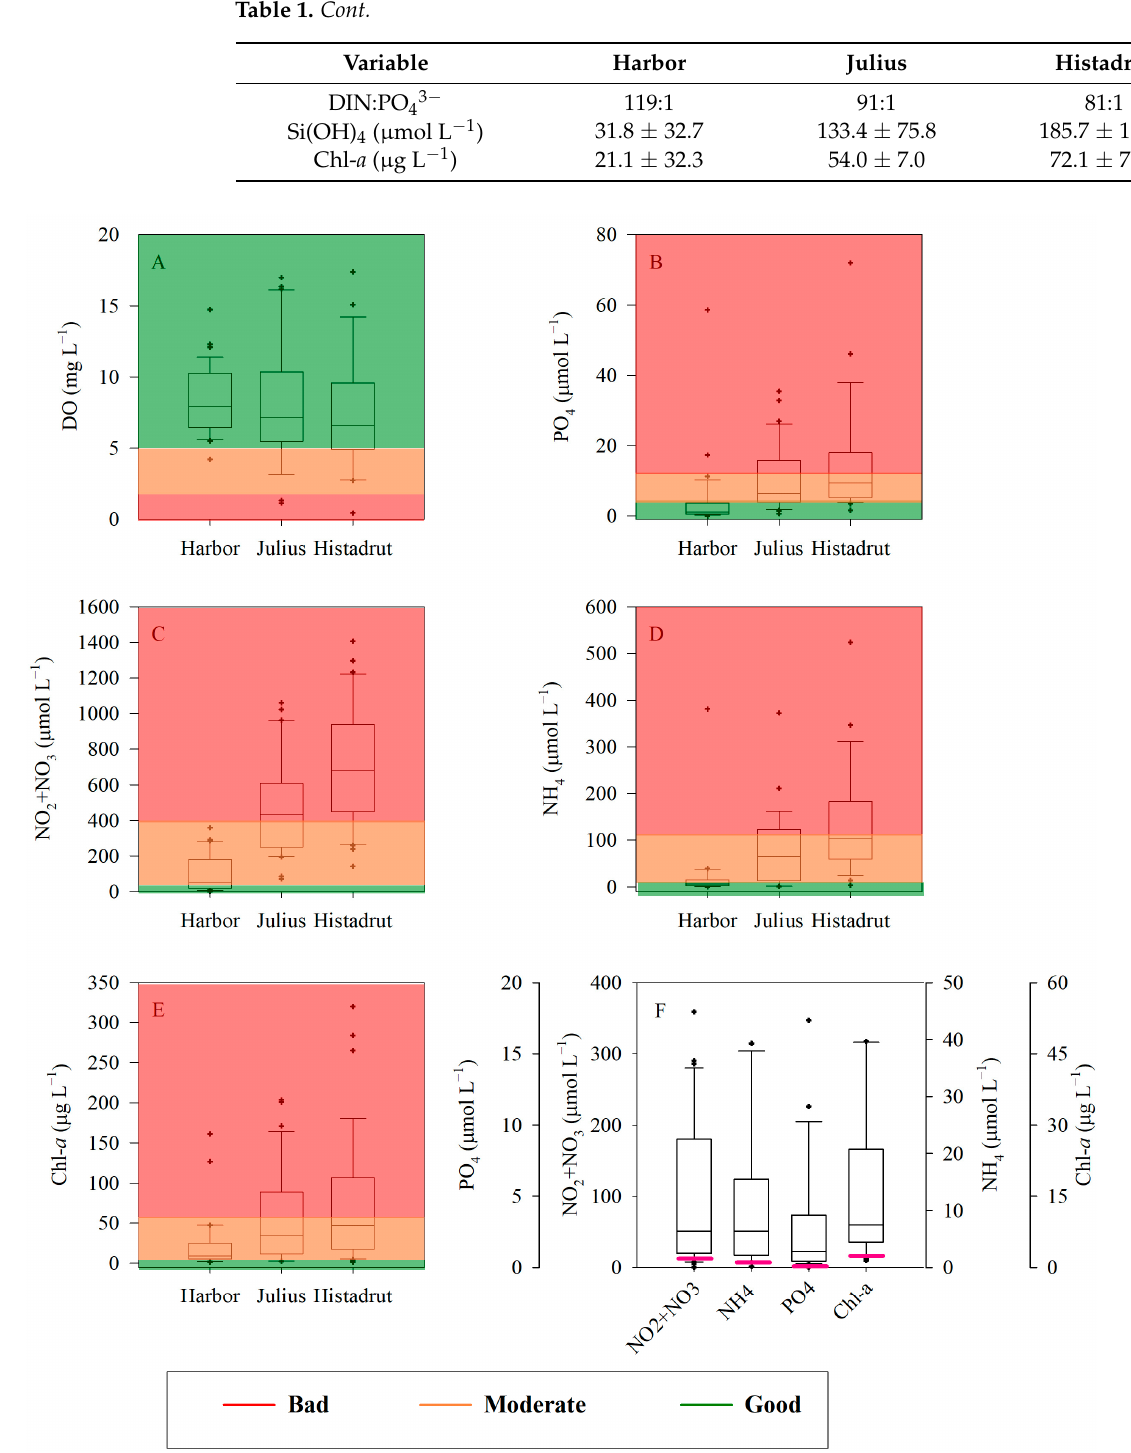
Figure 2. Whisker box plots showing the distribution of DO ( A ), PO 43 − ( B ), NO 2 − + NO 3 − ( C ), NH 4+ ( D ), and chl- a ( E ) in the surface water of the Kishon Estuary between 2002–2021. Background colors represent the water quality thresholds as suggested here for small stratified inland estuaries (see Table 2), where red stands for bad water quality, orange for moderate, and green for the good ecological state. The nutrients and chl- a threshold between good ecological status (GES) and non-GES for Haifa Bay coastal water (SE Mediterranean Sea) derived from Kress et al. (2019) [23] are shown as pink lines within the box plots generated for the harbor station ( F ).